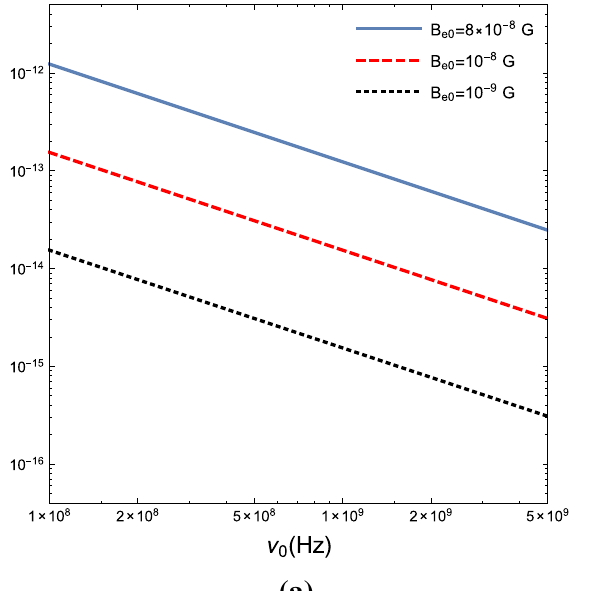
( a ) (b) Fig. 6 a Logarithmic scale plots of the degree of circular polarization B e 0 = 8 × 10 − 8 G and | r | = 10 (dashed line), B e 0 = 10 − 9 G and | r | = 0 . 1 (dotted line) and B = 10 − 9 G and | r | = 10 (dotdashed P C ( T 0 ) given in (66) as a function of ν 0 ∈ [ 10 8 , 5 × 10 9 ] Hz for mag- e 0 netic field amplitude B e 0 = 8 × 10 − 8 G (continuous line), B e 0 = 10 − 8 line) are shown. In all plots we used a value of | Q i | = 10 − 6 and values of (cid:16) = π/ 4 and (cid:17) = π/ 3 with r ≡ U i / Q i . In both a and b the values G (dashed line), B e 0 = 10 − 9 G (dotted line) and | r | = 1 are shown. b Logarithmic scale plots of the degree of circular polarization P C ( T 0 ) of the parameters have been chosen in such a way that condition (65) is satisfied given in (66) as a function of ν 0 ∈ [ 10 8 , 5 × 10 9 ] Hz for magnetic field amplitudes B e 0 = 8 × 10 − 8 G and | r | = 0 . 1 (continuous line),